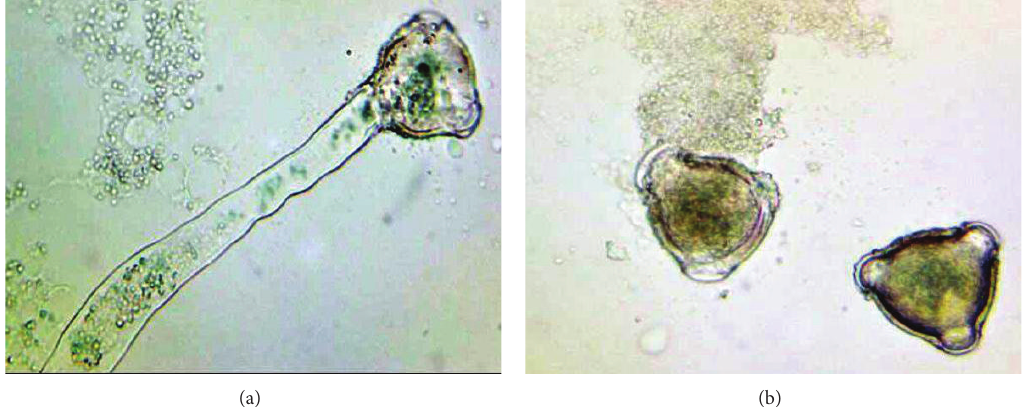
Figure 3: Pollen tube growth on germinated pollen (a); ungerminated pollen without a pollen tube (b) ( × 400).